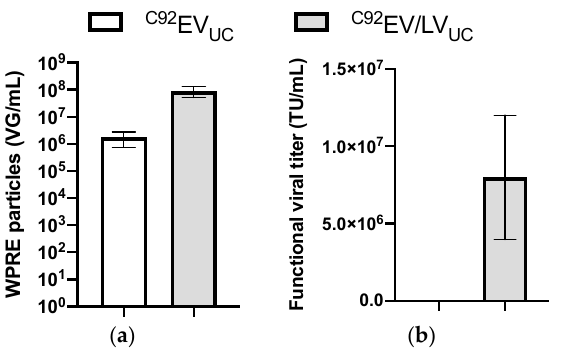
Figure 8. Comparison between C92 EV UC and C92 EV/LV UC . ( a ) Quantification of WPRE particles by ddPCR. ( b ) Quantification of functional viral titer by gene transfer assay (GTA). Error bars indicate SEM.